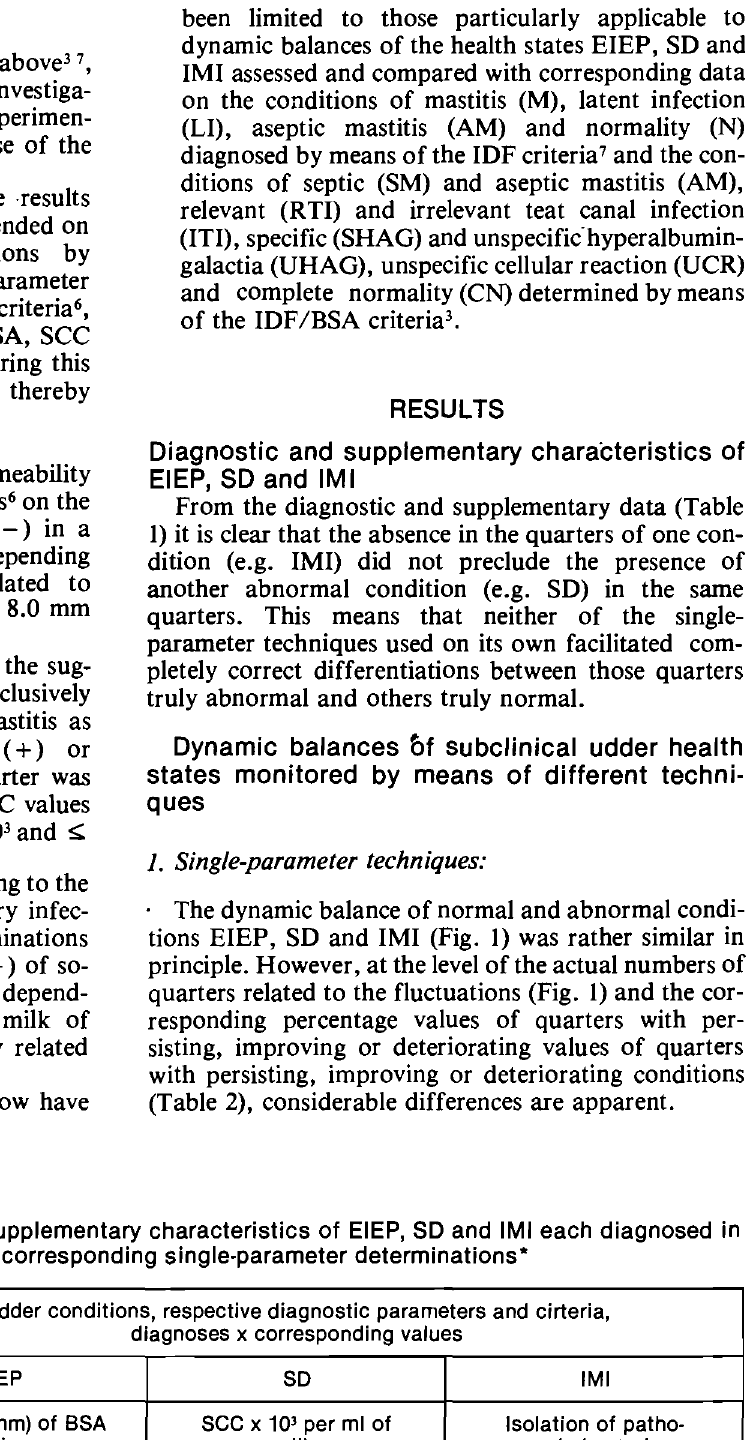
Table 1: General prevalence, diagnostic and supplementary characteristics of EIEP, SO and IMI each diagnosed in 1826 quarters by means of corresponding single-parameter determinations· Udder conditions, respective diagnostic parameters and cirteria, diagnoses x corresponding values EIEP SO